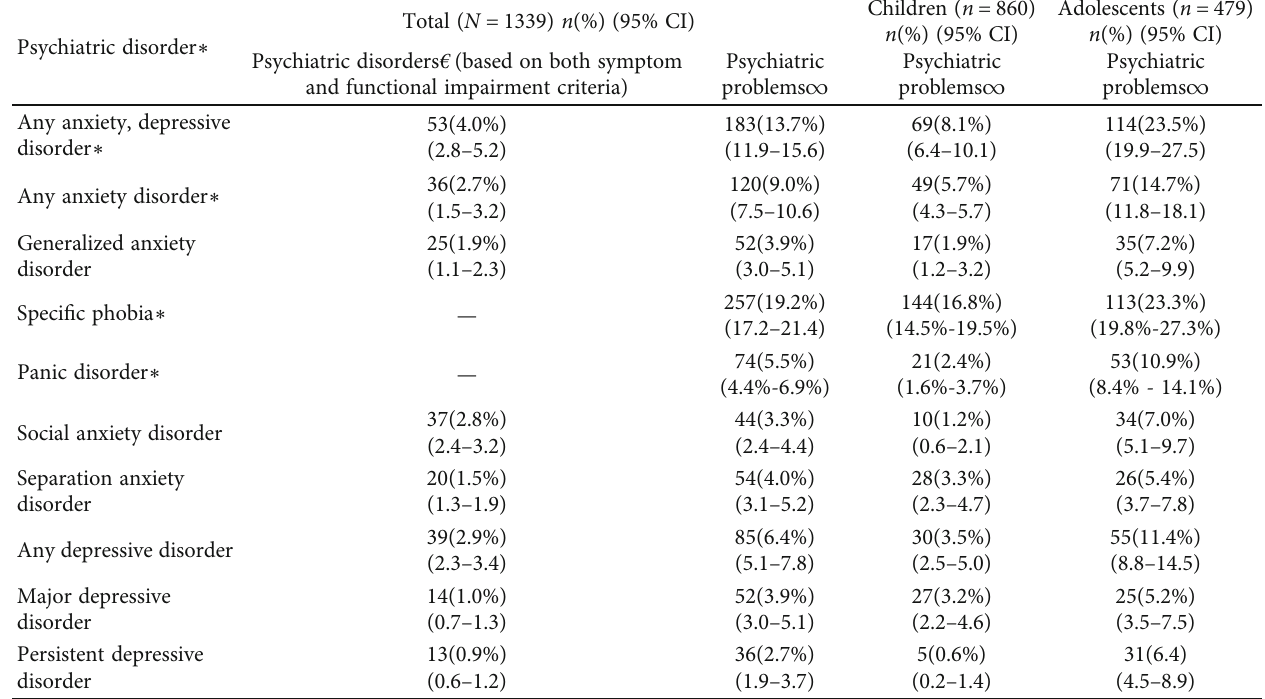
Table 3: Anxiety and depressive disorders by child